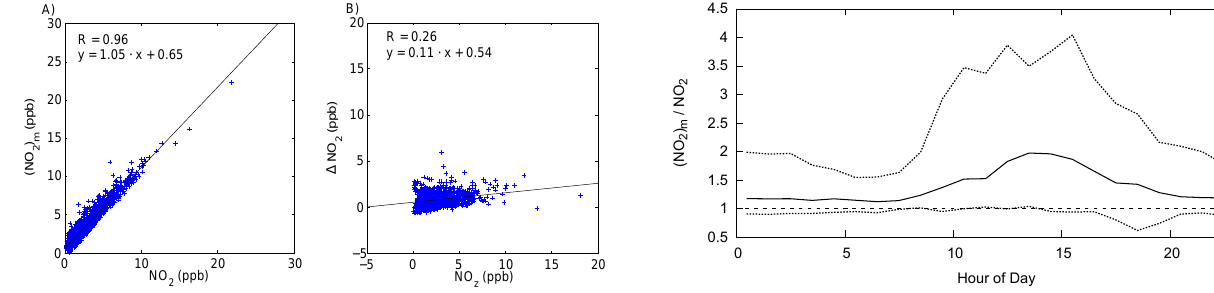
Fig. 6. (A) Comparison of collocated high-time resolution NO 2 measurements made by heated molybdenum converted (vertical axis) and photocatalytically converted (horizontal axis) chemilumi- nescence monitors. The solid line is the best-fit linear regression. (B) Comparison of difference between molybdenum converted and photocatalytic NO 2 measurements with NO z measurements (taken by BC2 monitor).